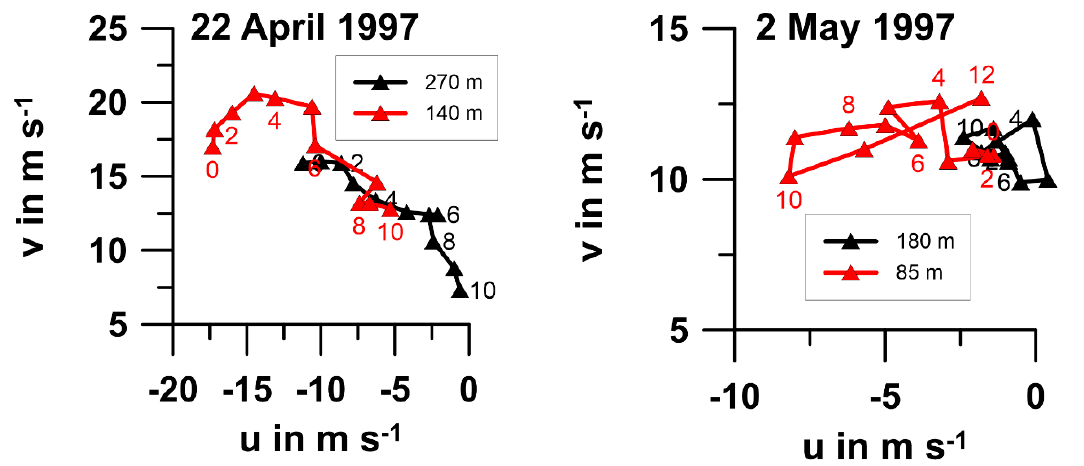
Figure A3. Simulated hodographs (mod) for 00:00–10:00 UTC 22 April 1997 for heights of 140 m (red) and 270 m (black) and for 00:00–12:00 UTC 2 May (hourly values) for heights of 85 m (red) and 180 m (black). Labels are the time in UTC.